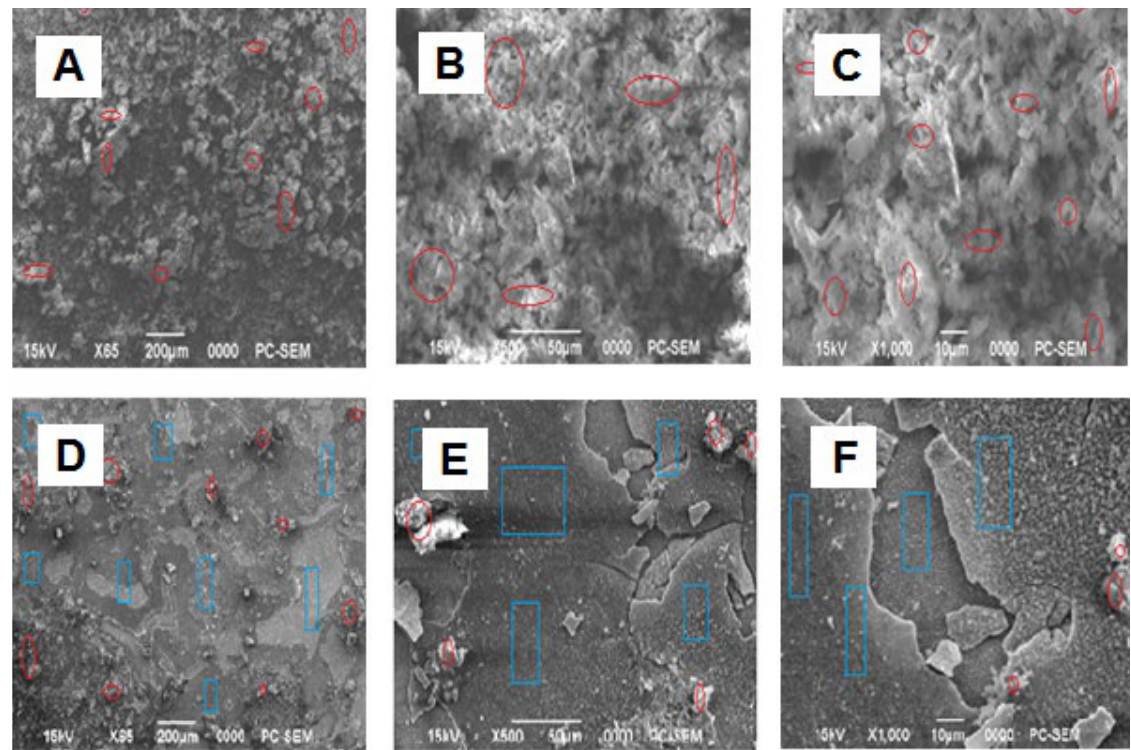
Figure 1. SEM micrographs of N80 steel samples incubated in SRB contaminated anaerobic environment for 90 days at 37 °C (Control) (A, B, and C), and incubated in SRB contaminated anaerobic environment for 60 days at 37 °C then treated by biocide2 CHIMEC 7660 and left for another 30 days at 37 °C (Treatment) (D, E, and F). (A and D) represent an X65 magnification with a scale bar of 200 µm, (B and E) represent an X500 circles refer to bacterial biofilms and the blue rectangles are cleared areas. magnification with a scale bar of 50 µm, (C and F) represent an X1000 magnification with a scale bar of 10 µm.